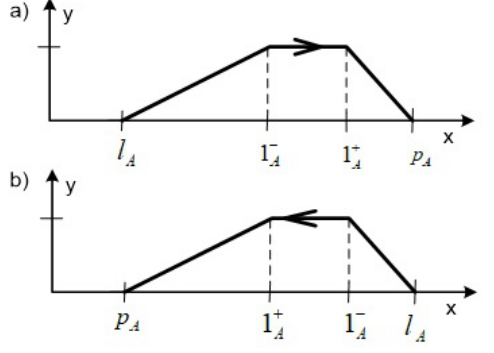
Figure 3. Fuzzy number that is ordered ( a ) positively or ( b )